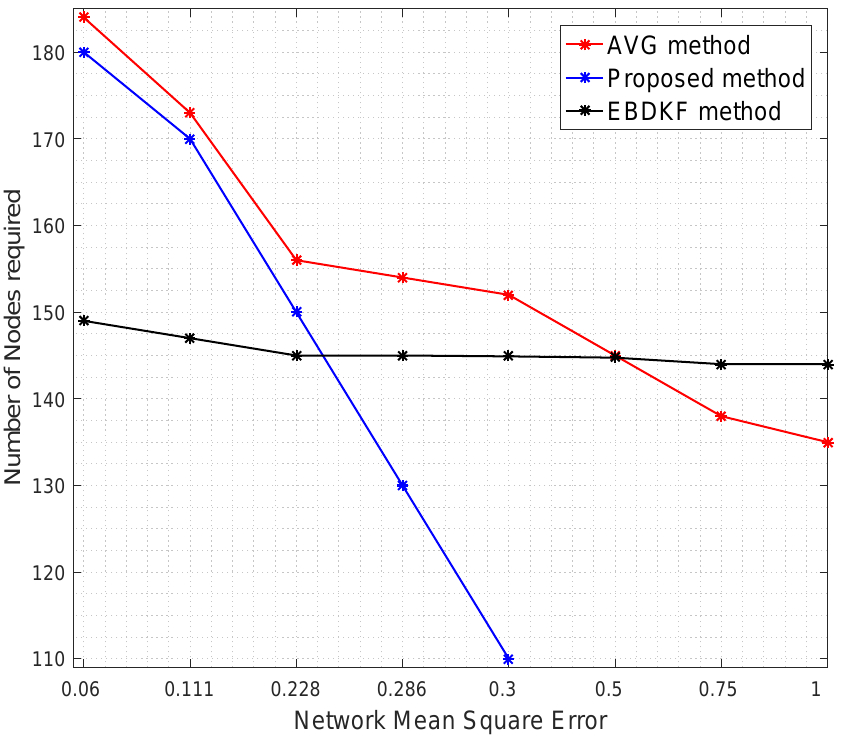
Figure 7. The number of nodes required to achieve a given percentage error using the proposed statistical method, average, and EBDKF data fusion for IoT